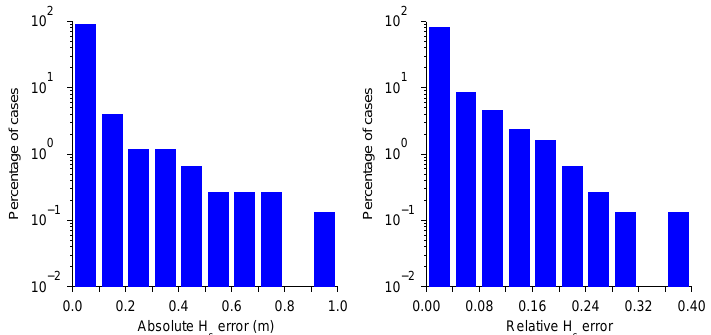
Figure 6. The difference in significant wave height when calculated from the original and corrected wave spectra measured by the G4 wave buoy. Absolute values (left panel) and relative values (right panel). The relative value is the difference between the original and corrected significant wave height normalised by the original significant wave height.